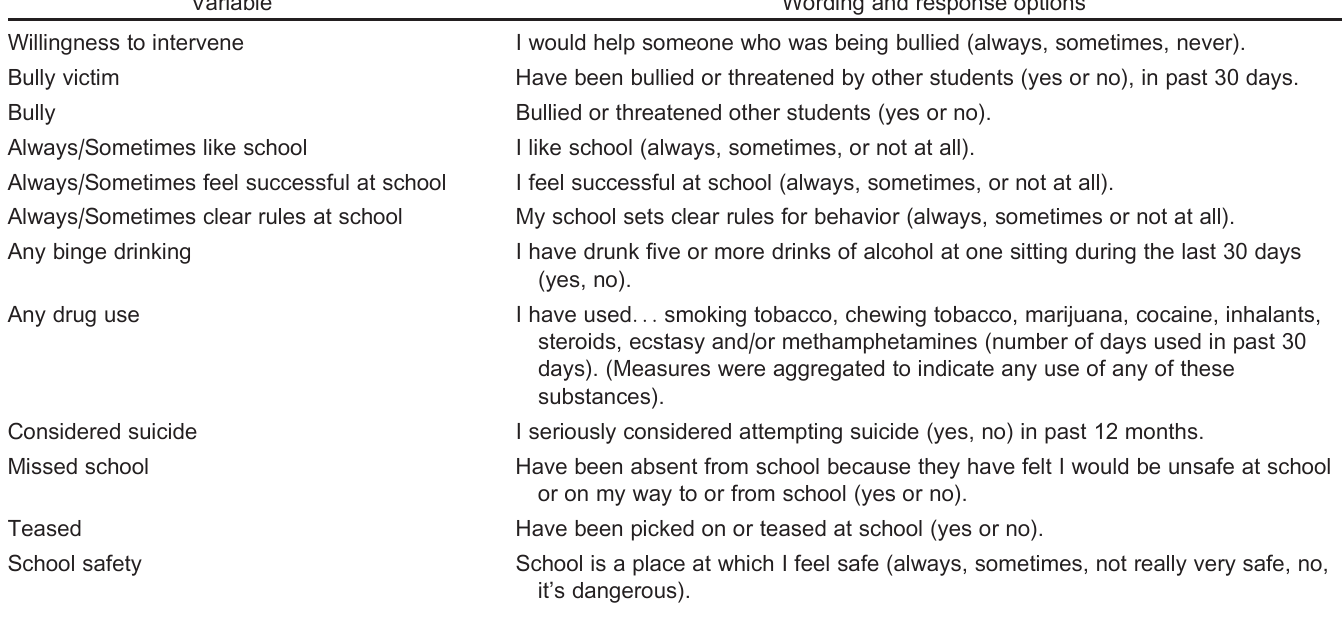
Table 1. Wording of variables included in the analyses of participants in the Georgia Student Health Survey II (2006).